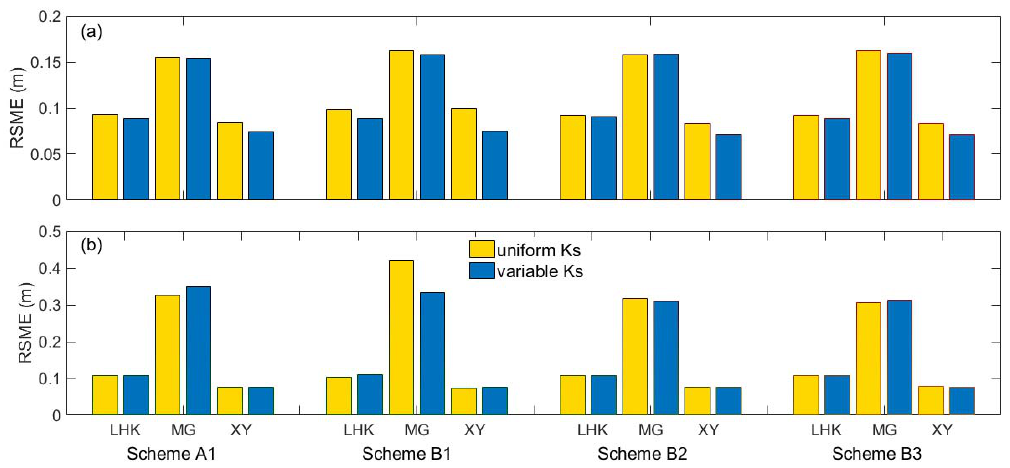
situ gauging stations. Panel 1-3 indicate results at Laohekou, Miaogang, Xiangyang stations, respectively. ( a , d , g ) Comparisons of simulated and in-situ observations during the calibration and validation periods. ( b , e , h ) The distribution of differences between simulated and in-situ observed WSE during the calibration periods. ( c , f , i ) The distribution of differences between simulated and in- situ observed WSE during the validation periods.